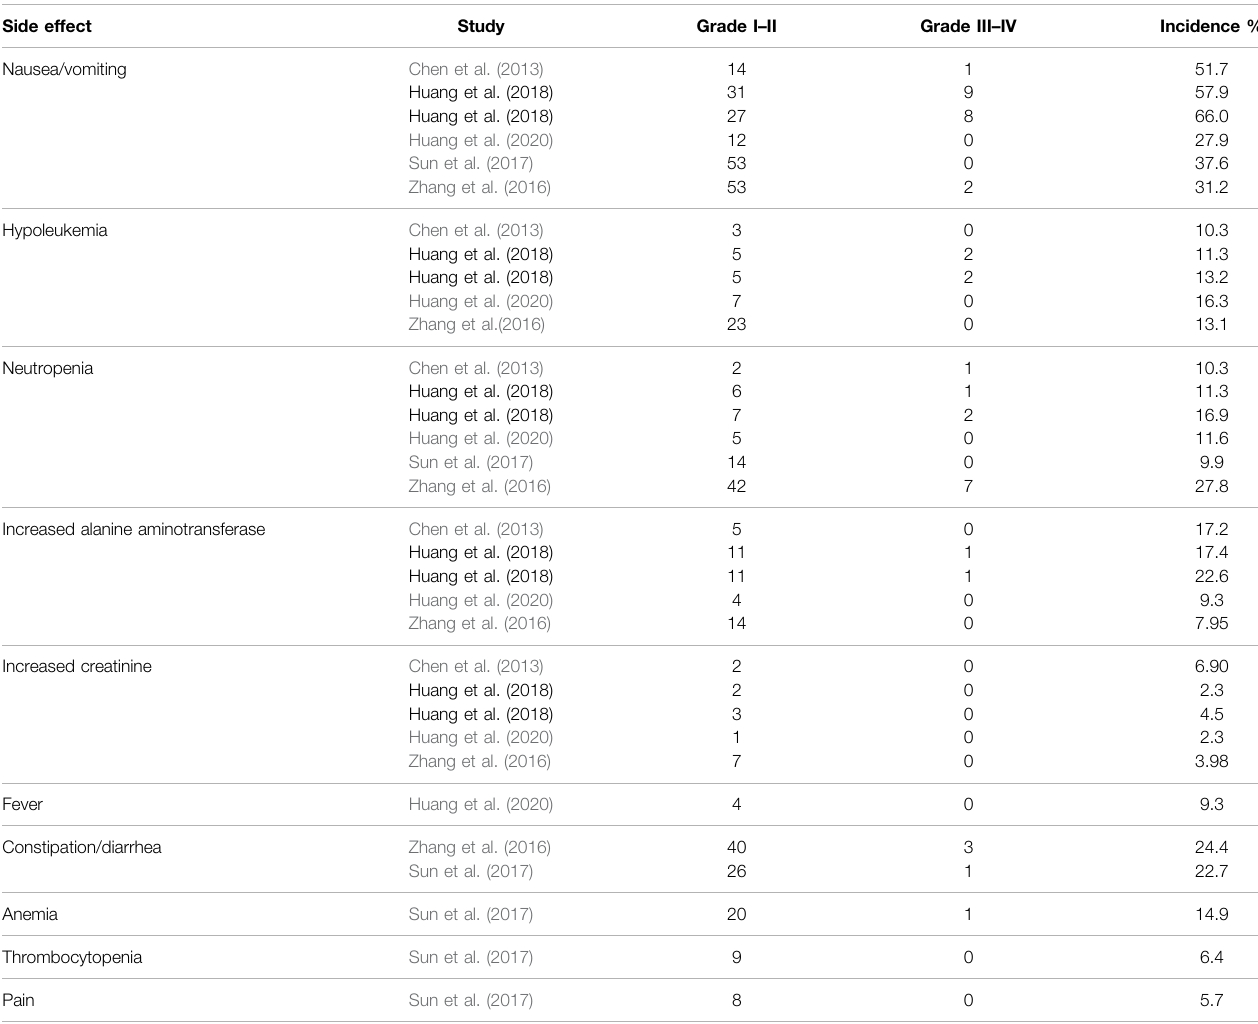
TABLE 3 | Adverse reactions of intra-arterial